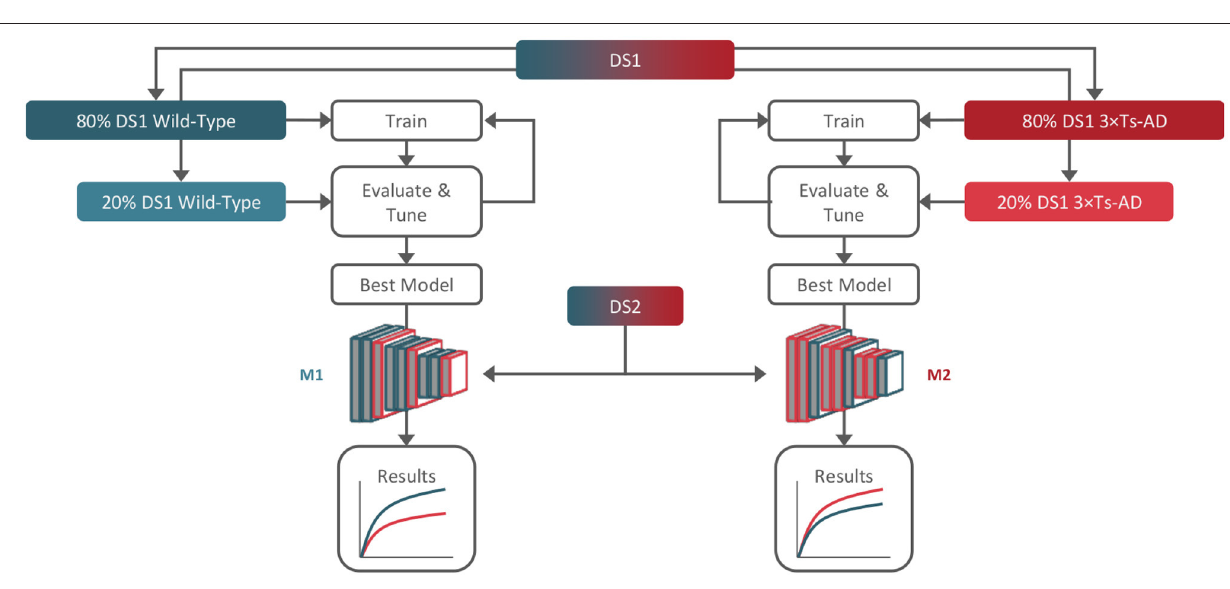
Frontiers in Aging Neuroscience |